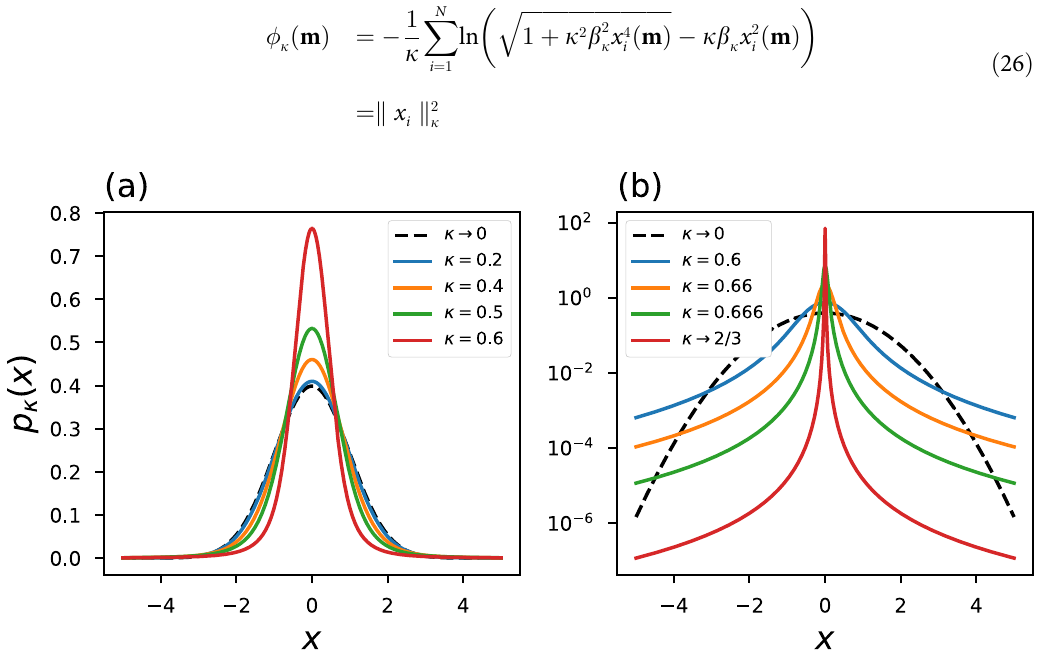
ffiffiffiffiffiffiffiffiffiffiffiffiffiffiffiffiffiffiffiffiffiffiffiffiffiffiffiffiffi